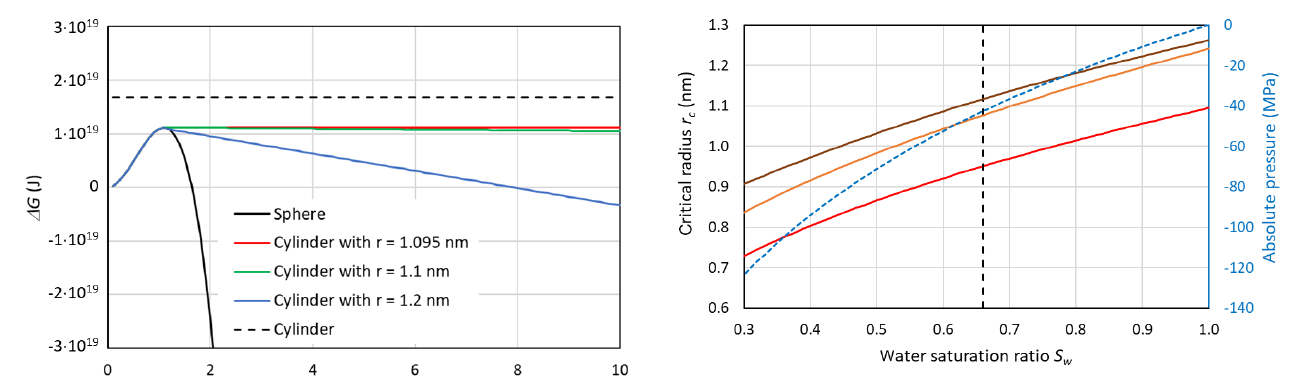
Figure 7. Dependence of the critical embryo radius on the water saturation ratio at 230K for ice nucleation within pores using Ick15 (red) and Mr10 (orange: n = 0 . 97; brown: n = 0 . 3) parameteriza- tions. Saturation with respect to bulk ice is indicated as the black dashed vertical line. The blue dashed line shows the negative pres- sure that builds up in porewater when the water saturation ratio de-